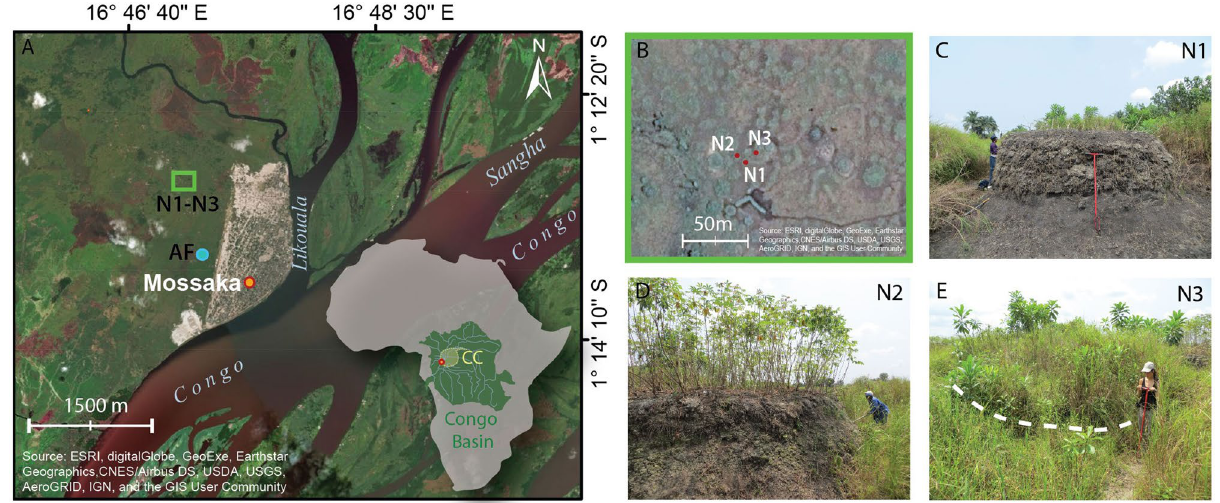
Figure 1. Study area and the four studied fields. (A) Study area in the cuvette centrale (CC) of the Congo Basin (satellite imagery from the ESRI ArcGIS base map). Inset map shows the location of the Congo Basin and CC in Africa; red-bordered orange dot (in both inset and main maps) indicates the city of Mossaka (built on sand pumped from the Congo River), green rectangle indicates location of RFs N1–N3 (1°12 ′ 59.48"S/ 16°46 ′ 56.27"E). Green dot indicates location of the abandoned field AF (1°13 ′ 30.52"S/ 16°47 ′ 15.71"E). (B) Fields N1-N3 shown from the air and (C–E) from the ground (satellite imagery from the ESRI ArcGIS base map). In (E) , the white dashed line shows the approximate border of the field). Photos (1–20 August 2017), Leonor Rodrigues and Tobias